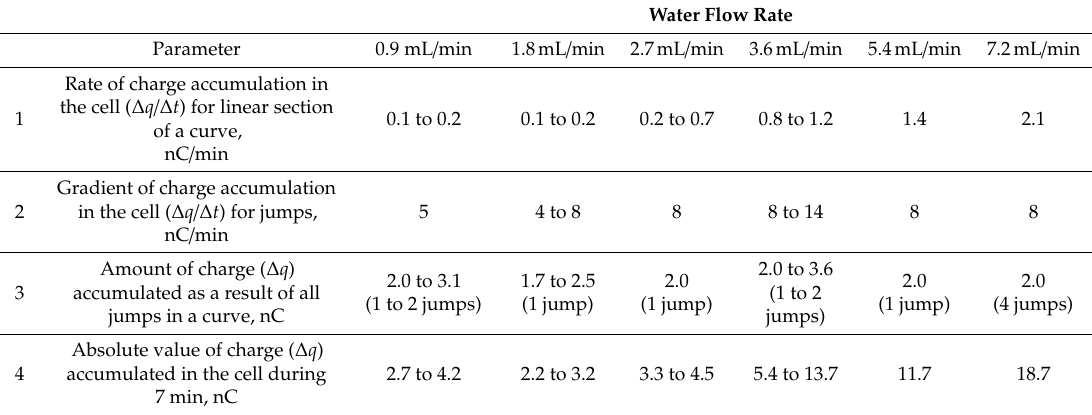
Table 1. Results of measurements of charge accumulated in the measuring cell at various flow rates of water.